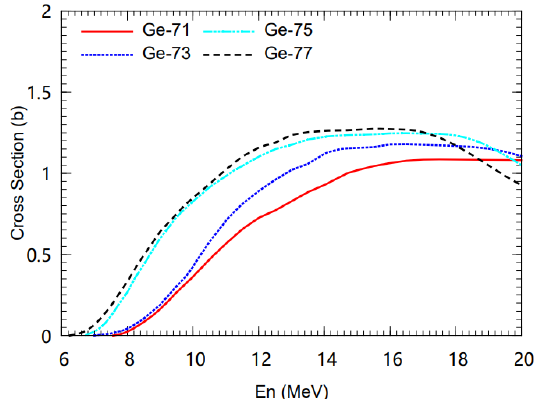
Fig. 4. The evaluated cross sections of 71,73,75,77 Ge(n,2n) in